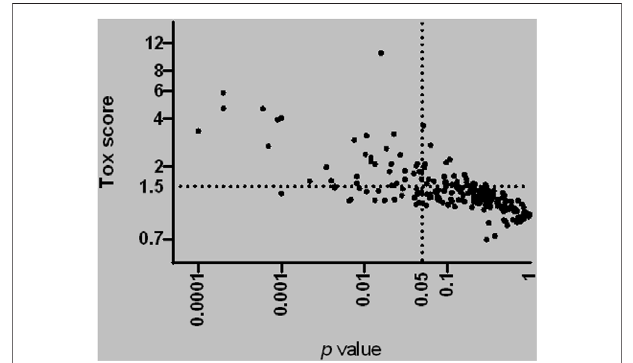
FIGURE 3 | Tox-score for all individual fl avor ingredients tested using real-time cell analysis. The horizontal straight line indicates a 1.5 EC50 ratio (ratio of EC50 base solution/EC50 fl avored solution). The vertical straight lines indicate a p-value equal to 0.05 on the right. Each dot corresponds to one individual fl avor